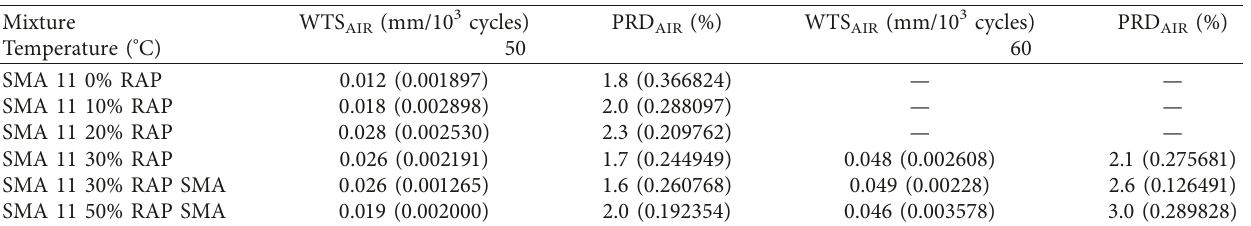
Figure 3: Sieve size distribution of the individual variants of the designed SMA 11 mixtures with various ratios and both types of RA. Table 5: Determined parameters of resistance against permanent deformation of SMA 11